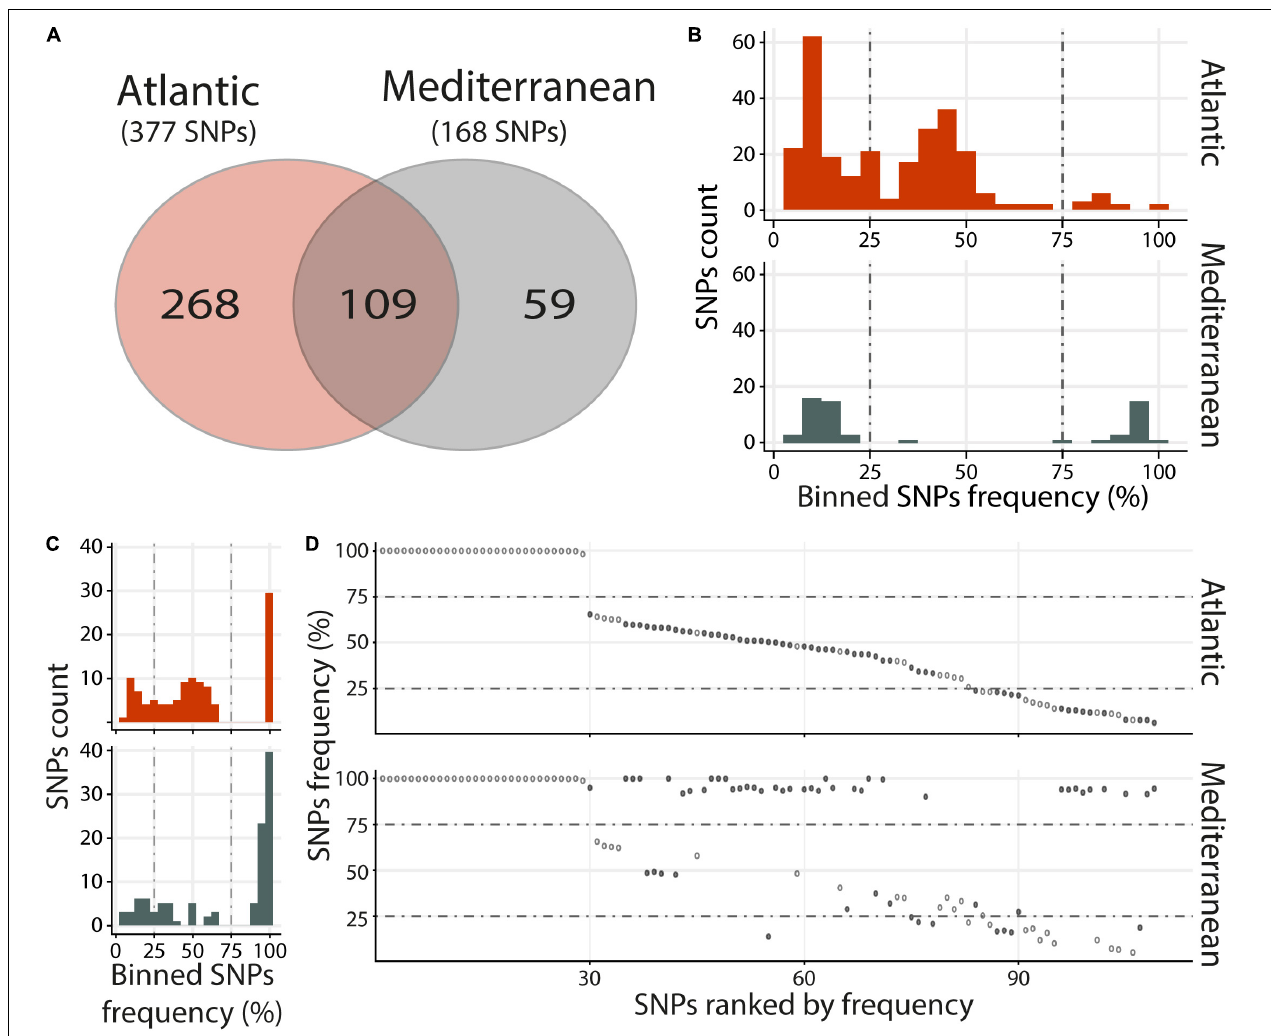
FIGURE 3 | Distinct heterogeneous viral populations within Atlantic and Mediterranean experimental infections. (A) Venn diagram representation of the number of specific and common SNPs within each experimental infection. The frequency distribution of SNPs for specific (B) and common (C) SNPs between Atlantic and Mediterranean experimental infections is illustrated in histograms. SNPs are binned at 5% intervals along the x -axis, and the number of SNPs in each bin is indicated on the y -axis. (D) Common SNPs are ordered according to decreasing variant frequency in Atlantic experimental infection and plotted for the same position in Mediterranean experimental infection. Black and white dots correspond to SNPs with different or similar variant frequencies (difference < 5%), respectively.